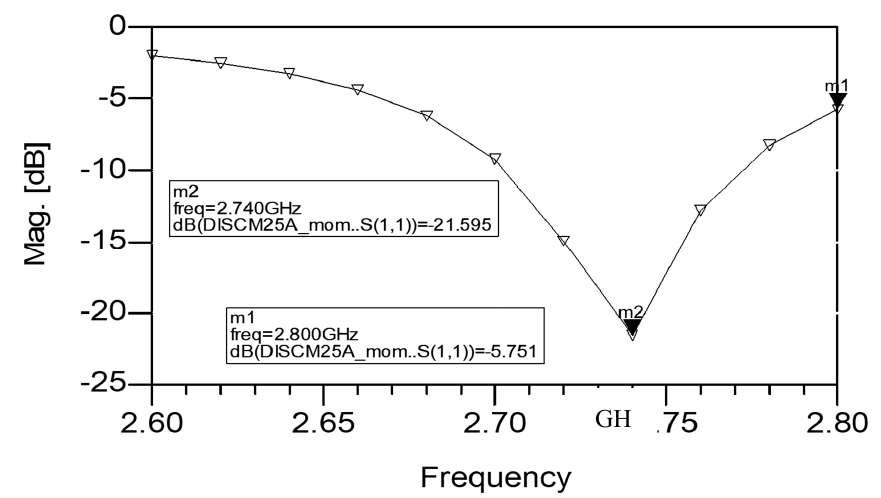
Figure 22. S11 parameter on a human body of the Double Layer Circular Patch Antenna with CSRRs.